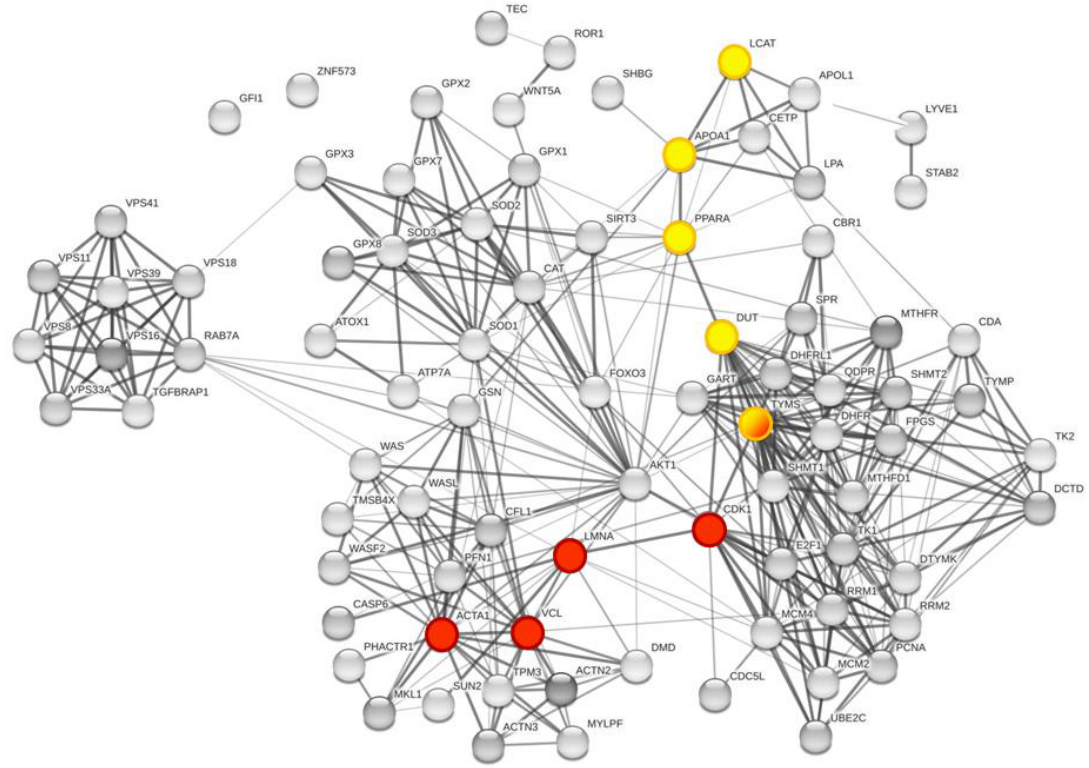
Figure 7. Global network visualization based on STRING pathway enrichment analysis focused on TYMS and DHFR. In the global network representation, the interaction pathway between the TYMS-DHFR protein network and the proteins of the panel identified through MS study are shown, respectively, in red and yellow. The represented nodes are the closest connection possible for the proteins of interest. The two main pathways identified are: TYMS-CDK1- LMNA -VCL- ACTA1 (red nodes) and TYMS-DUT-PPARA-APOA1- LCAT (yellow nodes). TYMS is half yellow/half